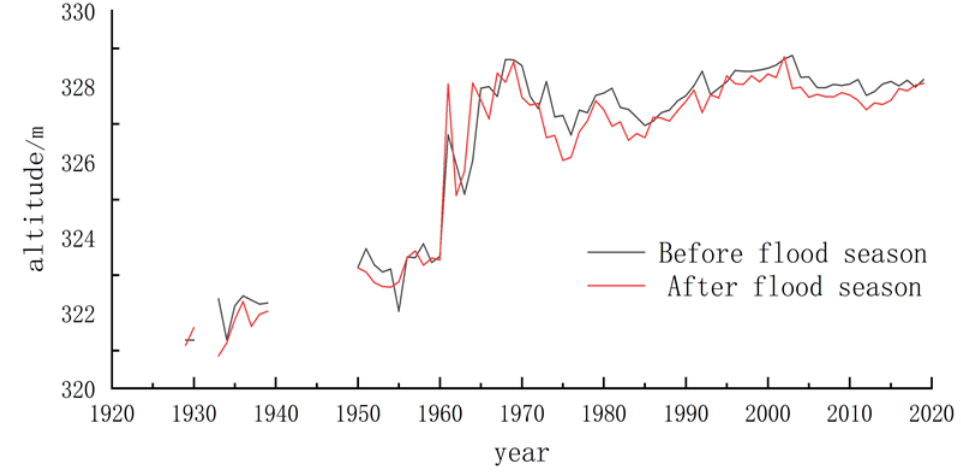
Figure 3. Annual average elevation change of water surface in Sanmenxia Reservoir area.